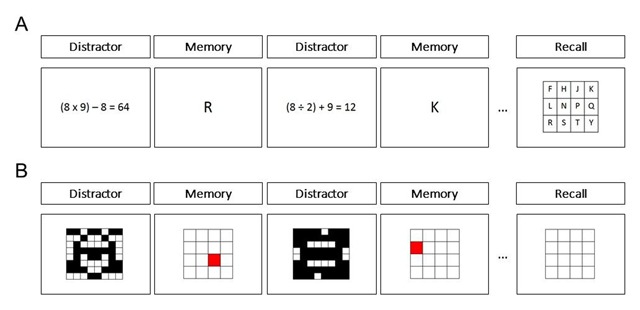
Procedure of the working memory task. (A) In the operation span task, trials with to-be-remembered letters and trials with distracting mathematical statements alternated in each sequence. At the end of each sequence, the letters were to be recalled by participants in correct order. Sequence length varied from 3 to 7. (B) In the symmetry span task, trials with to-be-remembered locations and trials with distracting symmetry judgments alternated in each sequence. At the end of each sequence, the locations were to be recalled in correct order. Sequence length varied from 2 to 5.